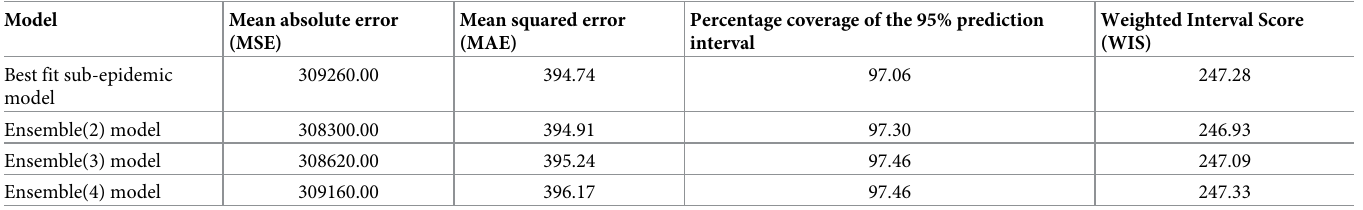
� The Ensemble( i ) model incorporates the top i ranked sub-epidemic models in the ensemble as described in the text.